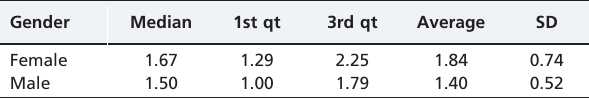
Table 3 – Differences between the right and the left radii according to gender.